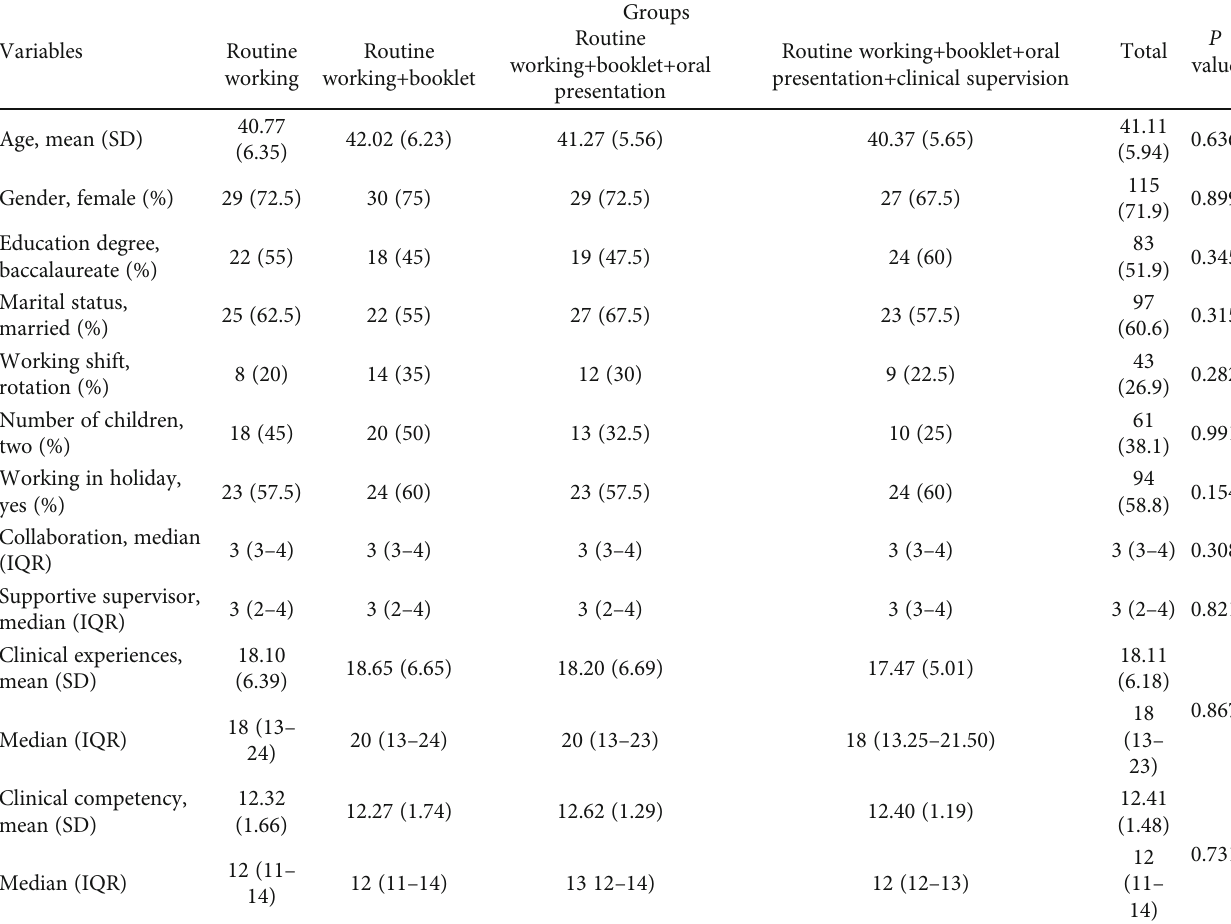
Table 1: Demographic variables of nurses in 4 educational groups ( n = 55 nurses per group).